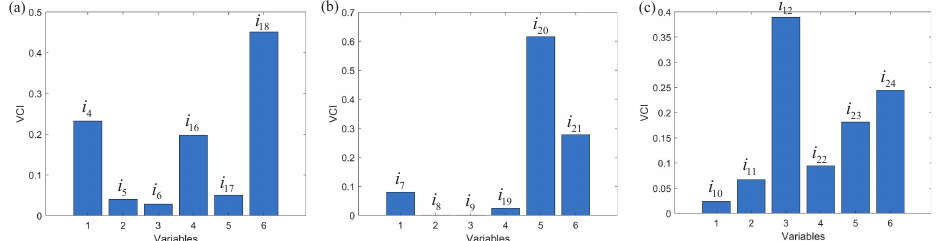
Figure A2. The variable isolation results in anode effect of aluminum electrolysis industrial process.